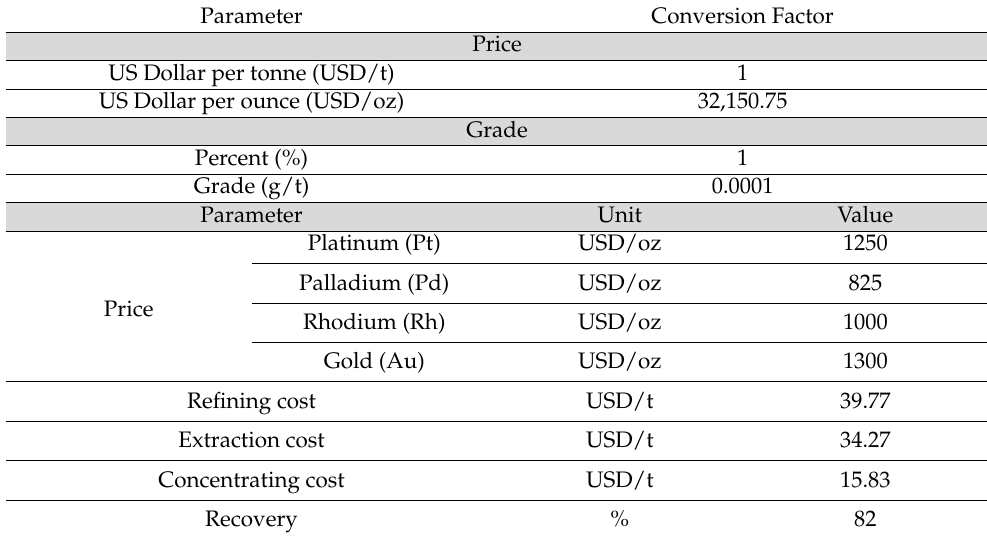
Table 2. Conversion factors and input values for economic block model construction. Source: Adapted from